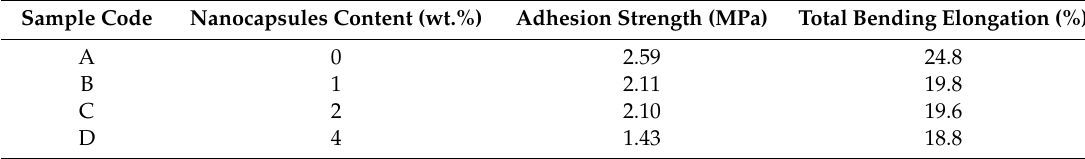
Table 2. Impact of nanocapsules content on the properties of the coatings.